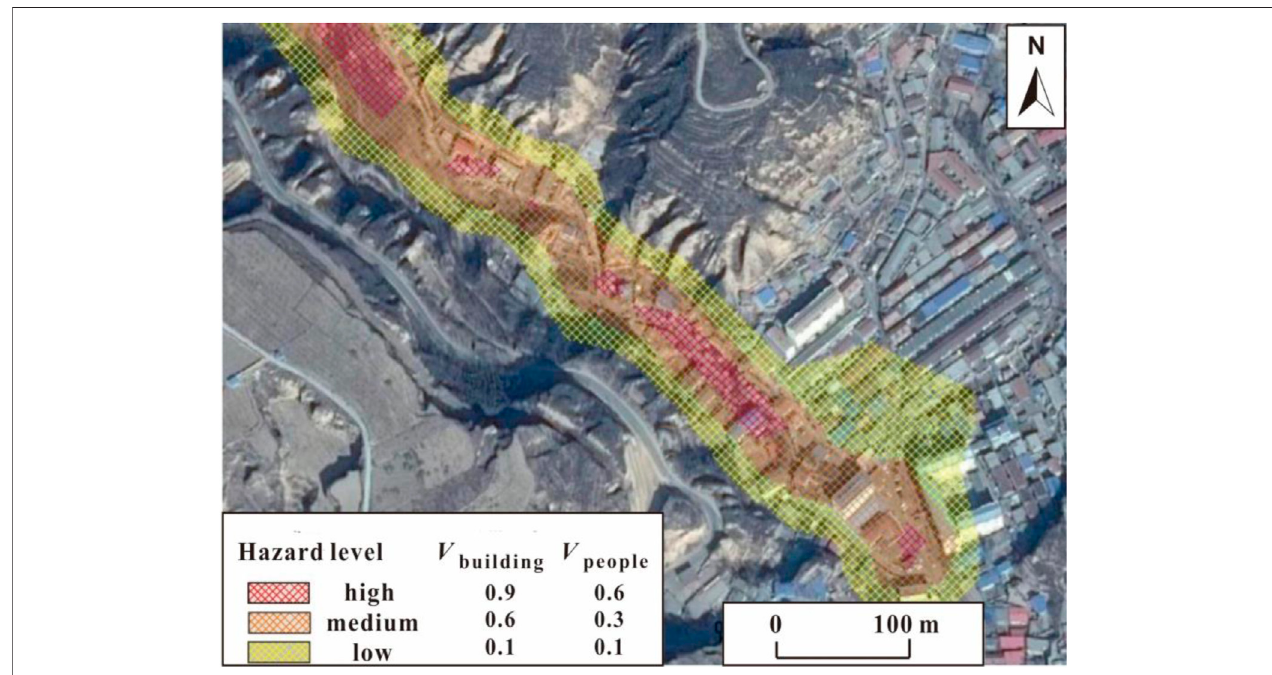
FIGURE 11 | A map showing the vulnerability of the elements at risk located at the lower part of the gully. V building : vulnerability of buildings; V people : vulnerability of people.